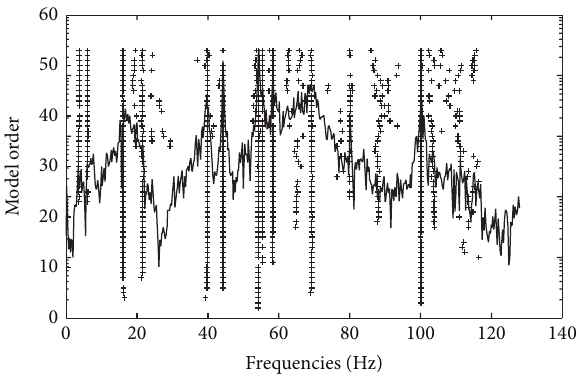
Figure 5: The stabilization diagram with new implementation.